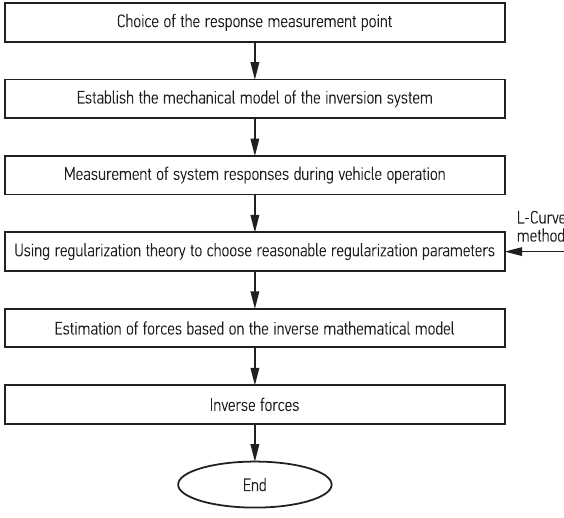
Fig. 5. Process of the proposed method for high-speed train’s wheel–rail contact force